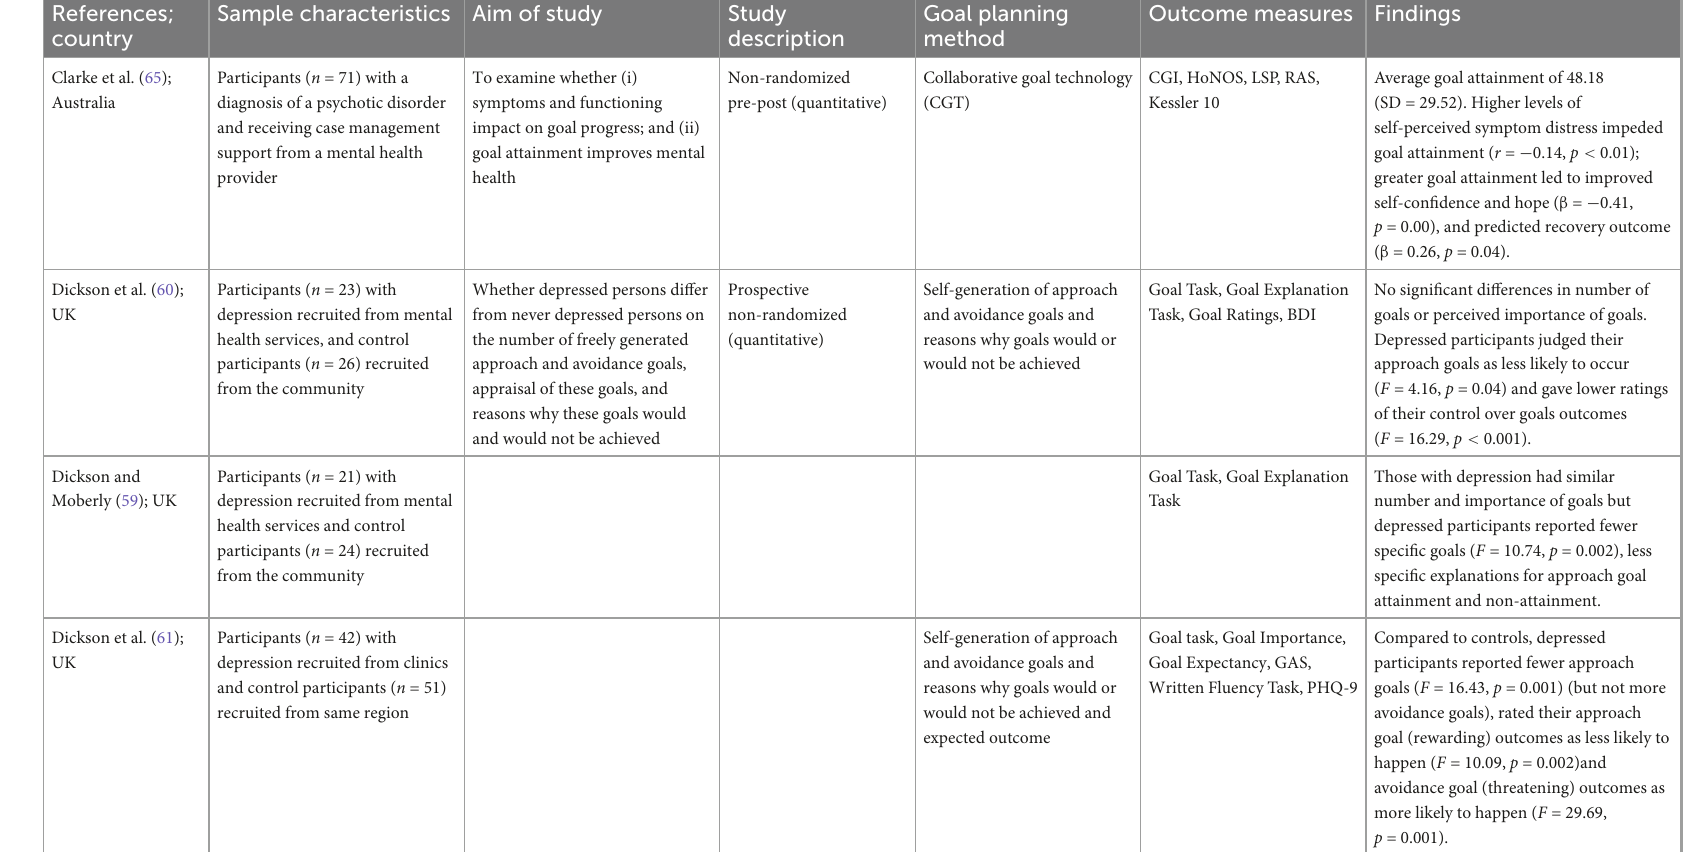
TABLE 3 Factors influencing goal planning and/or